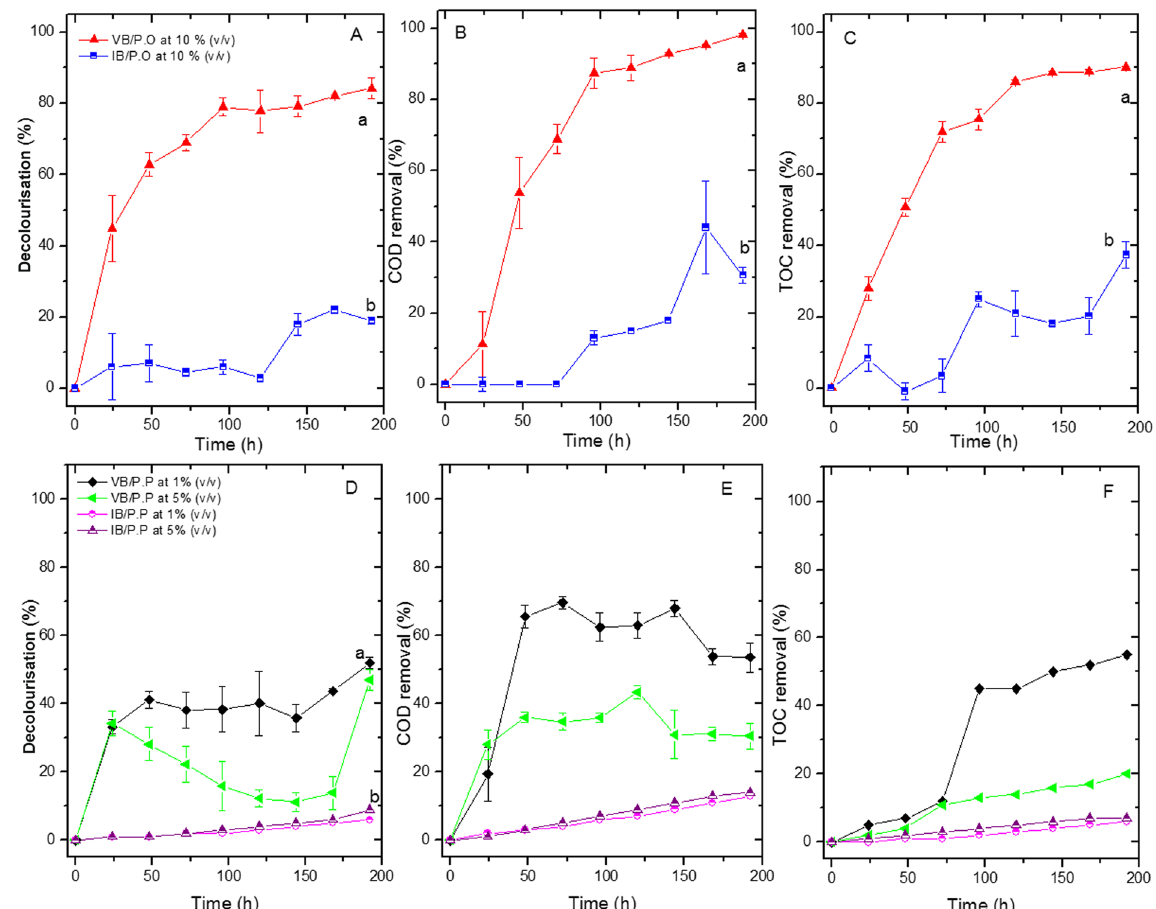
Figure 2. P. ostreatus viable biomass (VB/P.O) and inactive biomass (IB/P.O) removal curves. ( A ) Decolourisation. ( B ) COD removal. ( C ) TOC removal. P. pastoris viable biomass (VB/P.P) and inactive biomass (IB/P.P) removal curves. ( D ) Decolourisation. ( E ) COD removal. ( F ) TOC removal. For all cases, after 192 h of treatment, significant differences were observed between VB/P.O and IB/P.O, ( p < 0.0001), with decolourisation values of 84 and 19% and COD removal of 90 and 37%, respectively. For P. pastoris , VB removal percentages for 5 and 1% SBL increased gradually with time, with higher values for VB than for IB. Decolourisation values of 47.5 and 52% were observed, along with COD removal of 30 and 53% and TOC removal of 20 and 55%. Lower values were observed for IB: 9 and 6.3% for decolourisation, 14 and 13% for COD removal and less than 10% for TOC. The letters represent heterogeneous groups obtained after Tukey test analysis. The letter a corresponds to the best treatment, followed by the letter b. The bars represent the Mean ± SD (n = 3) for